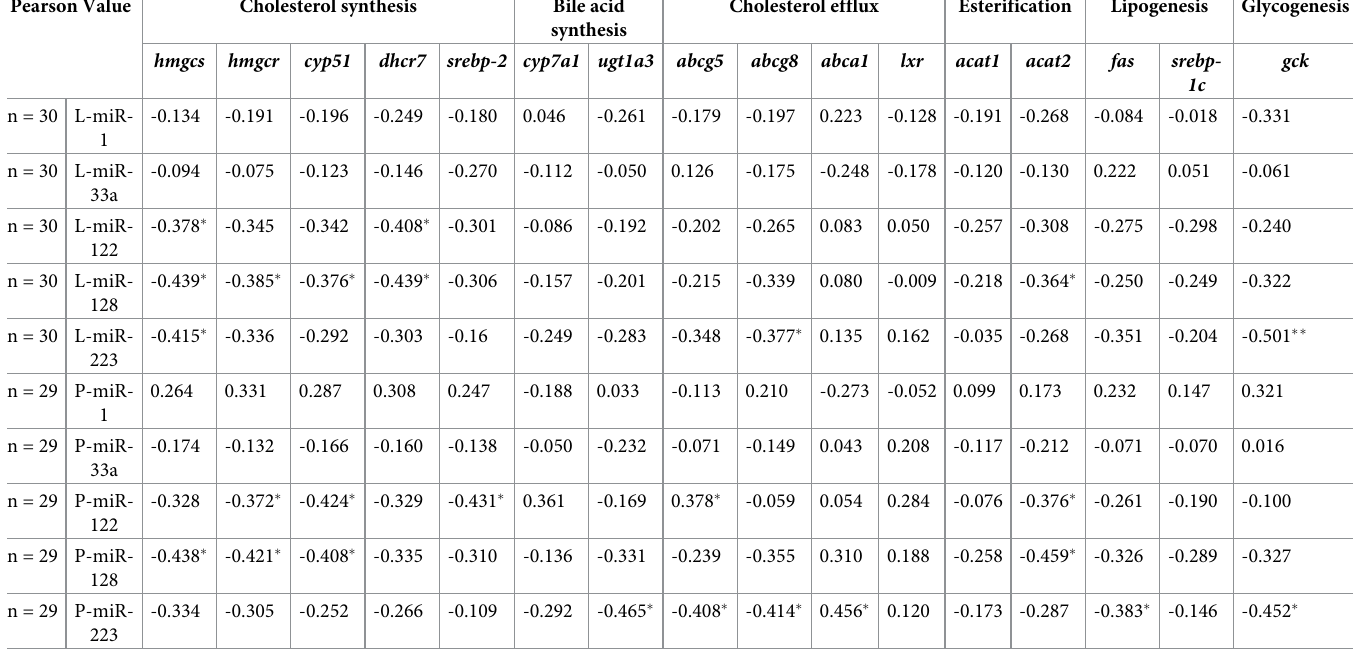
Results showed that hepatic and circulating levels of miR-122 and miR-128 positively corre- lated with each other ( P < 0 . 05 ) whereas, no correlations were found for miR-1 and miR-223 ( P > 0 . 05 ) (Table 7). Table 6. Correlations of hepatic gene expression involved in cholesterol metabolism, miRNAs expression in the liver, and miRNAs level in the plasma of rainbow trout. Pearson